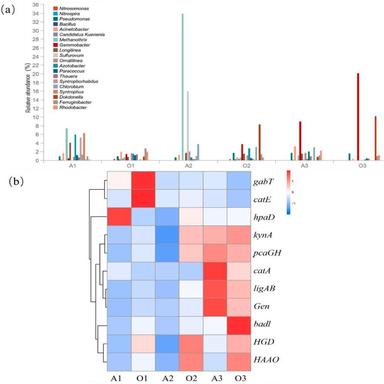
(a) Dominant microbial species and (b) heatmap of functional genes linked to AOCs degradation; tryptophan 2,3-dioxygenase (kynA); 4-aminobutyrate aminotransferase (gabT); 3-hydroxyanthranilate 3,4 dioxygenase (HAAO); 3,4-dihydroxyphenylacetate 2,3-dioxygenase (hpaD); gentisate 1,2-dioxygenase (Gen); homogentisate 1,2-dioxygenase (HGD); protocatechuate 4,5-dioxygenase (ligA/B); protocatechuate 3,4-dioxygenase (pcaG/H); catechol 1,2-dioxygenase (catA); catechol 2,3-dioxygenase (cat E).